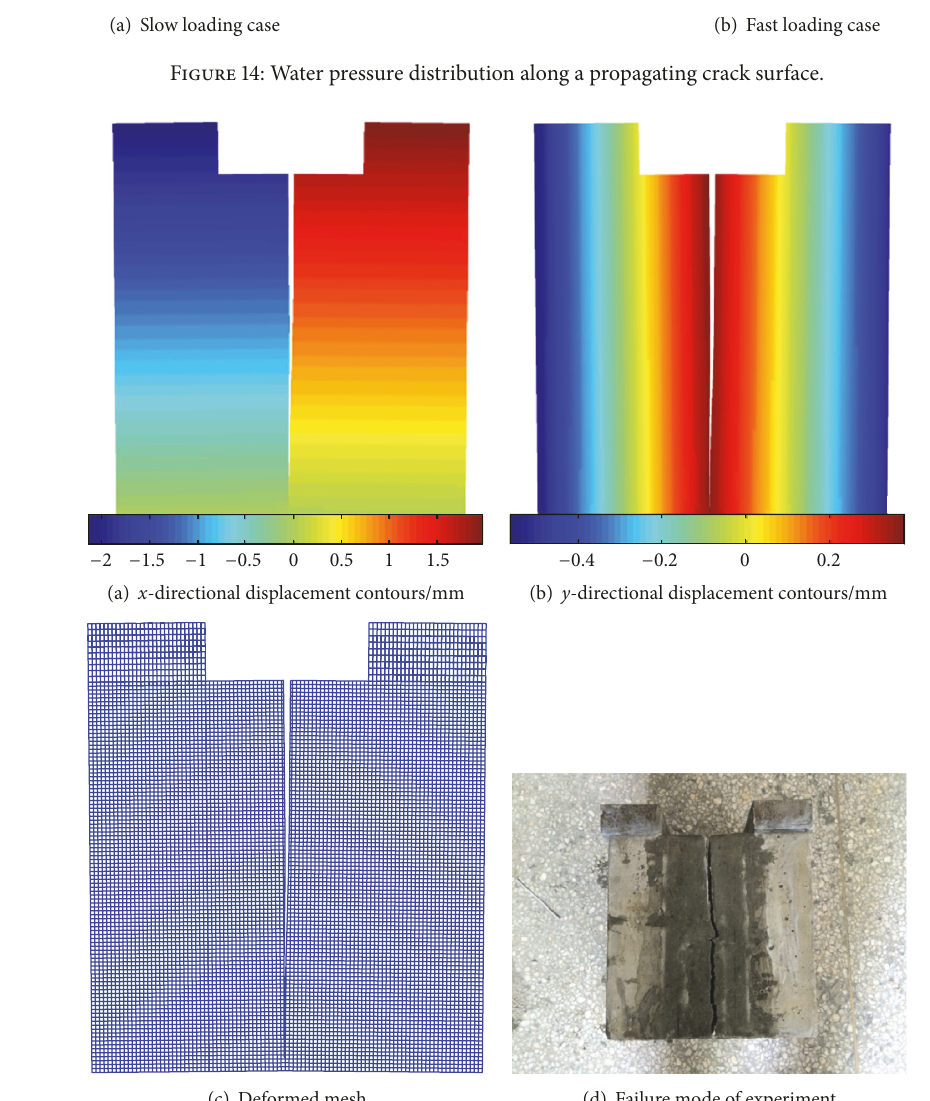
Figure 15: Failure mode for slow loading case with 𝑝 𝑛 = 0.2